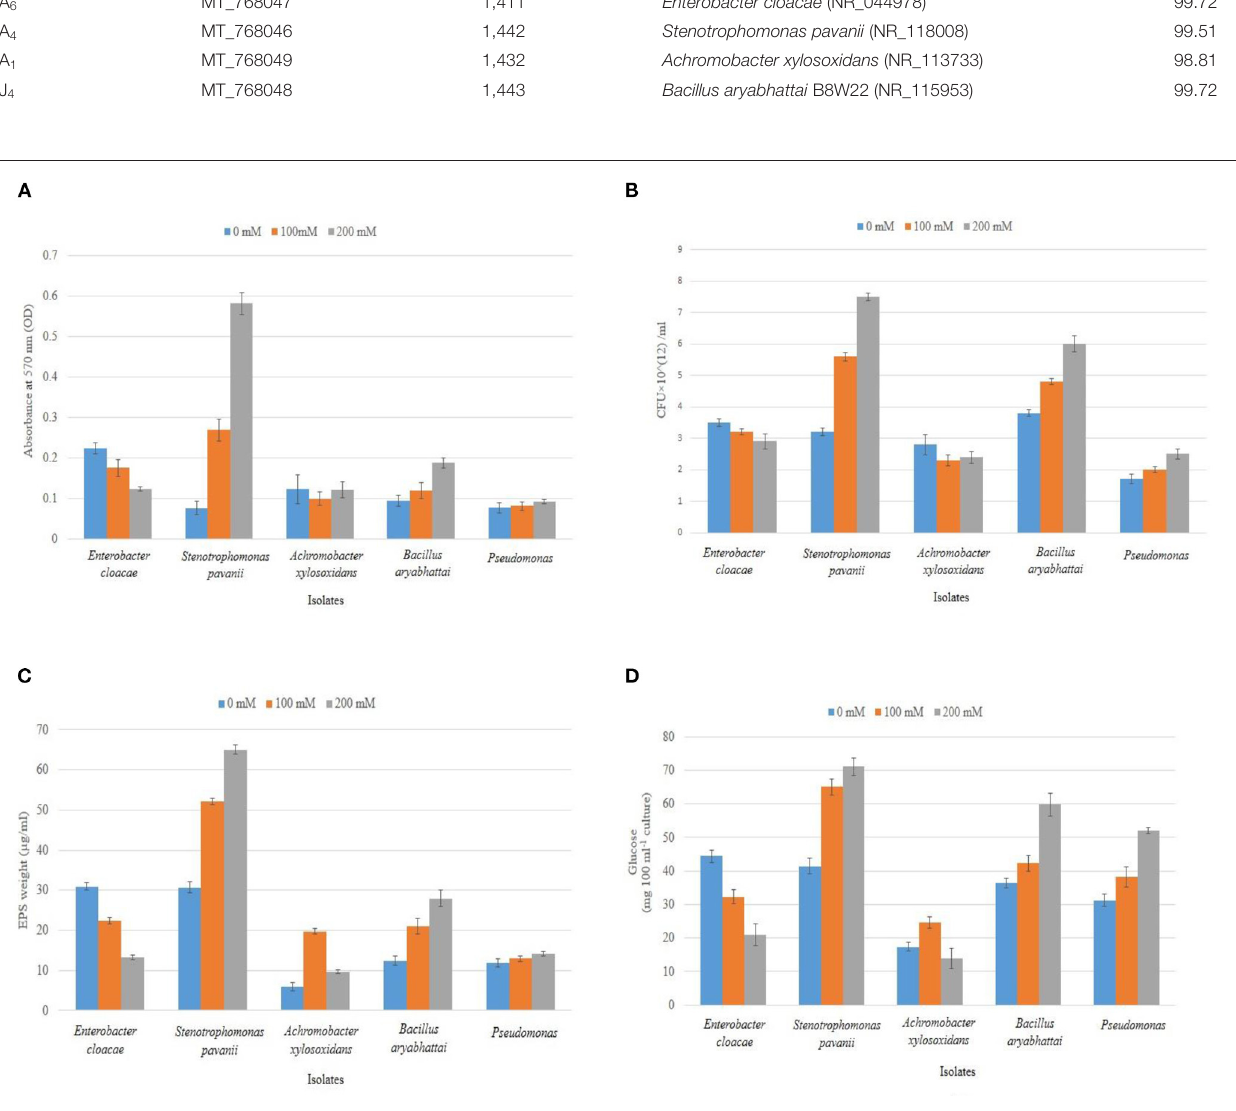
FIGURE 4 | Biofilm formation of the identified isolates was studied in microtiter plates (A) and under soil condition (B) , followed by the estimation of respective EPS materials in dry weight (C) and their corresponding Glucose content (D) at varying salt concentrations (0, 100, and 200mM NaCl). Error bars represent the mean ± SD ( n =